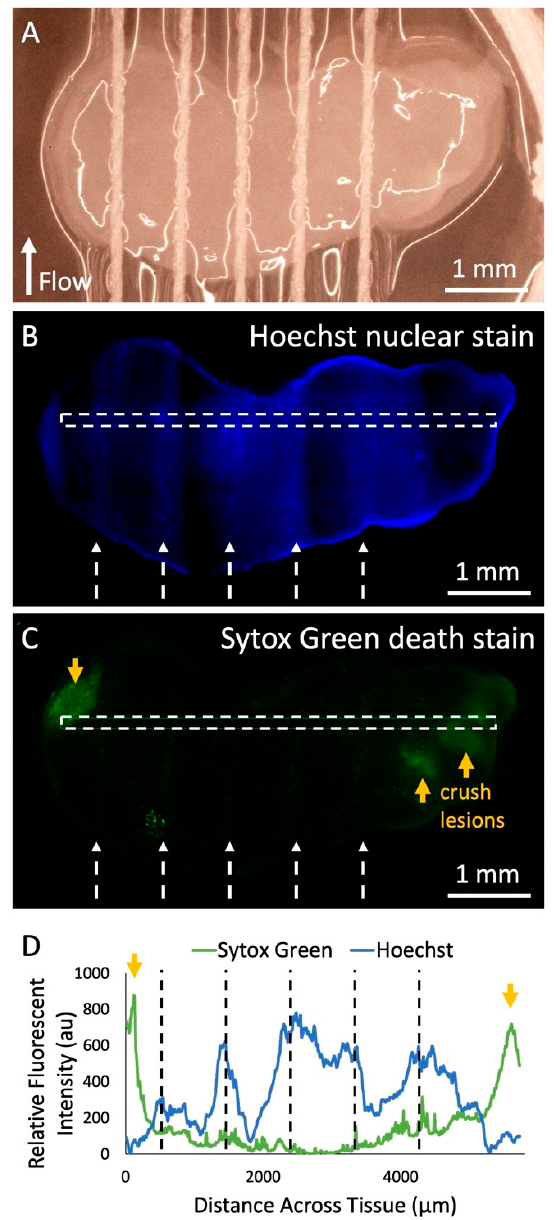
Figure 5. Fluorescent dye delivery to live tissue. ( A ) Photograph of threads across living human U87 glioma xenograft tissue slice in culture before dye delivery with the device. ( B ) Fluorescent image of Hoechst nuclear stain delivery to the tissue after running the device with the Hoechst solution in all lanes for 2 h in the incubator, removal from the device, and staining with the Sytox Green cell death stain. White dashed arrows indicate the thread locations and the direction of flow. ( C ) Fluorescent image of Sytox Green death stain of the tissue. Orange arrows indicate locations of intentional crush lesions that act as positive controls for tissue death. ( D ) Hoechst and Sytox Green fluorescent intensity